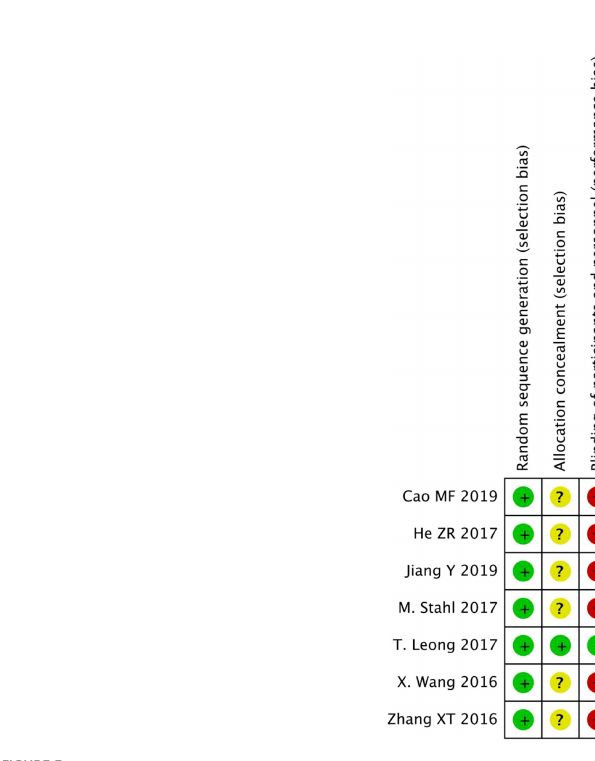
FIGURE 3 Risk of bias summary for seven